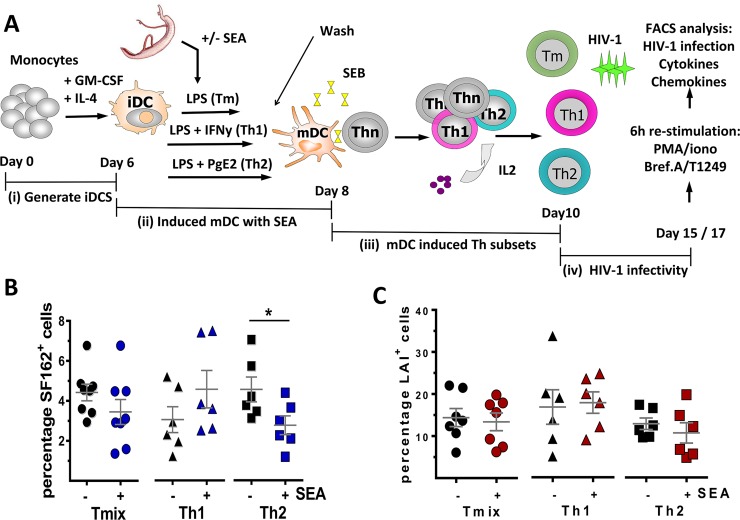
HIV-1 SF162 (R5) infection is altered in T-cell cultures induced by SEA exposed DCs.(A) Schematic overview of our in vitro model system. Isolated iDCs are matured under Tmix, Th1 or Th2 promoting conditions either in absence or presence of parasite antigen. Subsequently, the matured DCs were co-cultured with naïve CD4+ T-cells in combination with Staphylococcal Enterotoxin B (SEB). The induced effector memory T-cell populations (Tmix, Th1 or Th2 cell cultures) were then infected with HIV-1 after which, among others, the percentage of HIV-1 infected cells was measured. (B) Percentage of SF162+ cells in Tmix, Th1 and Th2 cell cultures induced by DCs unexposed (black) or exposed to SEA (blue). (C) Percentage of LAI+ cells in Tmix, Th1 and Th2 cell cultures induced by DCs unexposed (black) or exposed to SEA (red). (B and C) Results of 6 to 8 independent experiments using at least 5 different donors combined and depict are the mean value and SEM. *p<0.05.